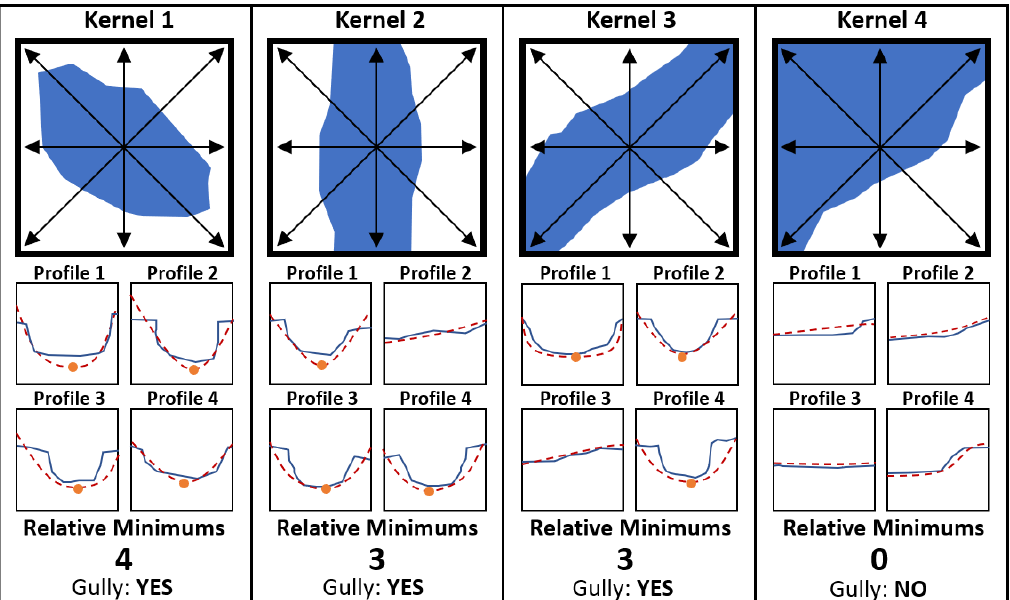
Figure 6. Interpretation of first and second derivatives of the adjusted second order polynomial as an application to study terrain morphology and detect gullies with MPCA.